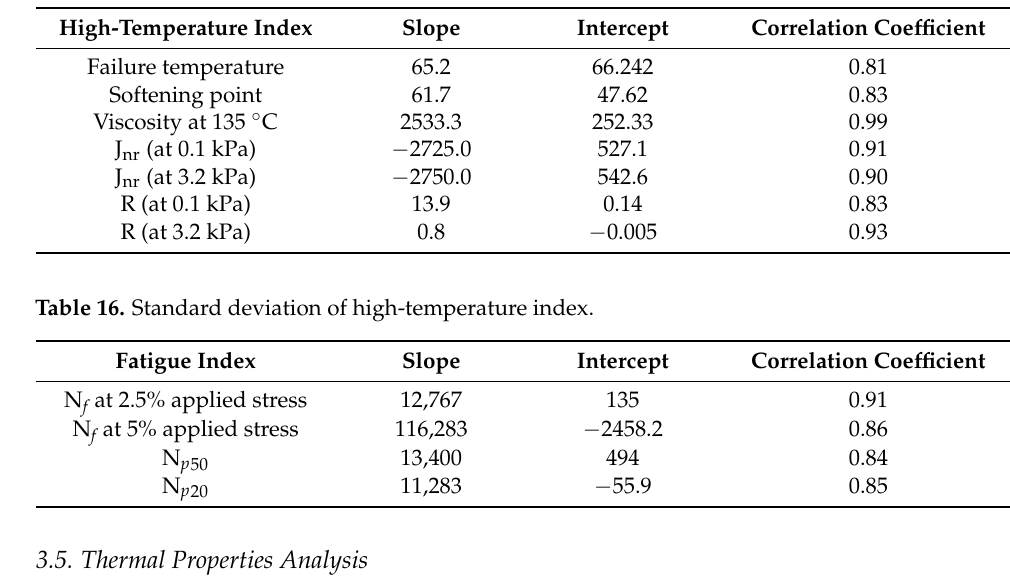
Table 15. Standard deviation of high-temperature index.